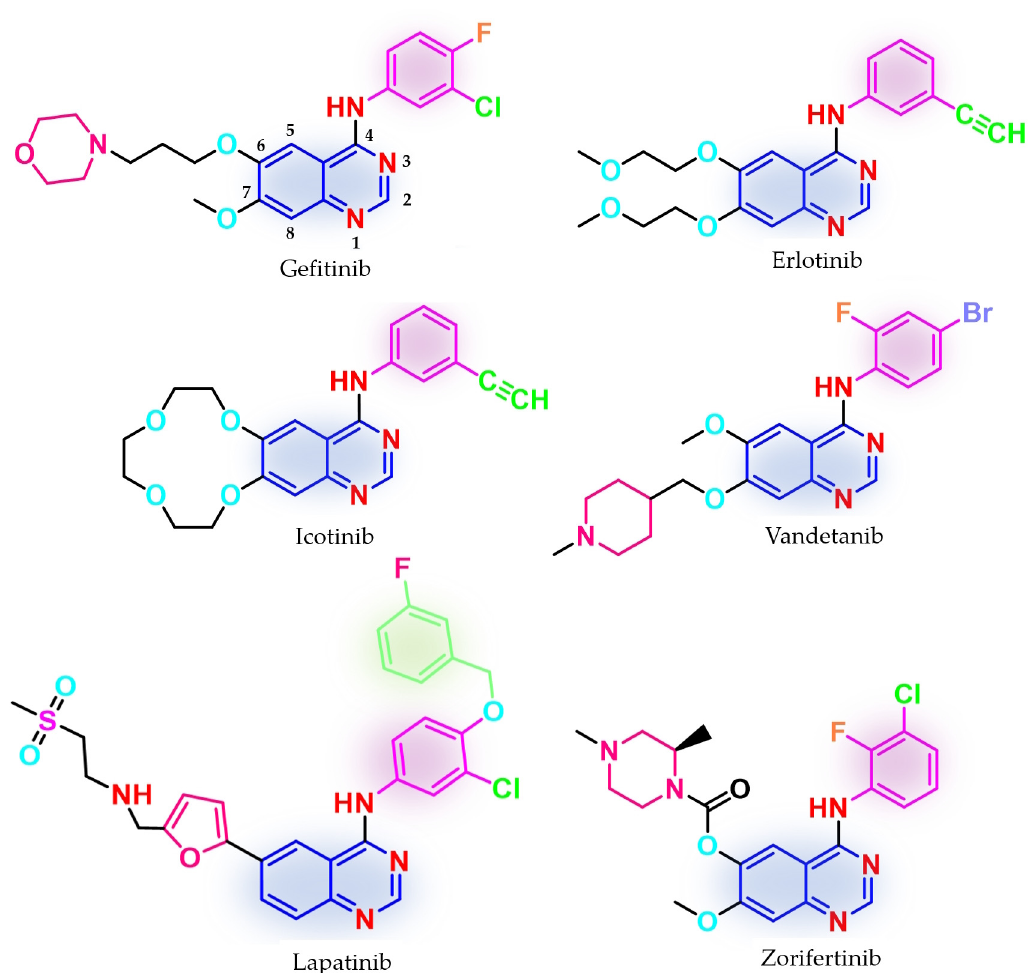
Figure 1. Chemical structures of first-generation quinazoline-based EGFR inhibitors approved in therapy and under clinical trial: gefitinib, erlotinib, icotinib, lapatinib, vandetanib, and zorifertinib. Other quinazoline-based TKIs, such as lapatinib (dual inhibitor of EGFR/HER2,